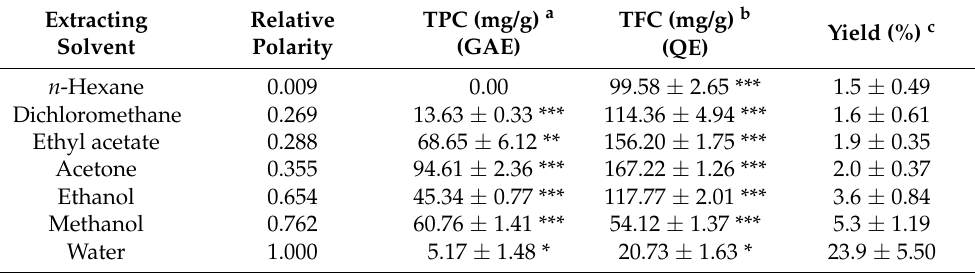
Table 1. TPC, TFC, and extraction yields of Morus alba L. with each extraction solvent. Extracting